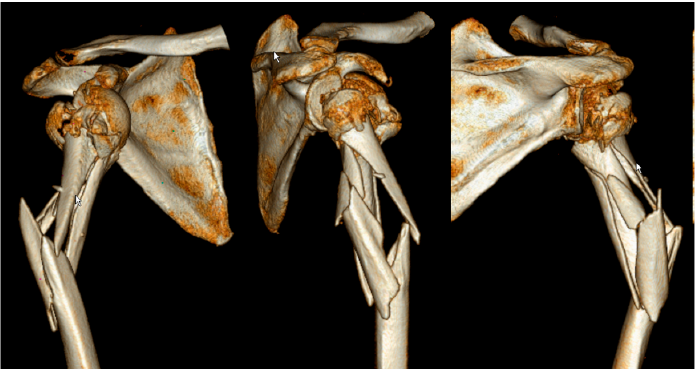
Figure 2. Example of a 3D computed tomography reconstruction of an extended dislocated inter- muscular humerus fracture according to Garnavos et al. [6]. Shown is the typical fracture extension from the fractured humeral head to the middle third of the humeral diaphysis. Divergent fragment displacement in the region of the proximal metaphysis is typical for extended intermuscular frac- tures due to the attached muscles.